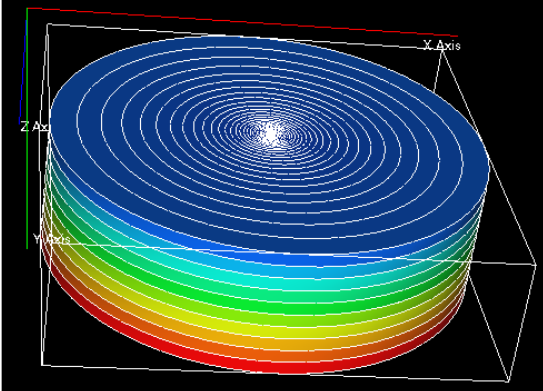
Figure 1—Reservoir model with